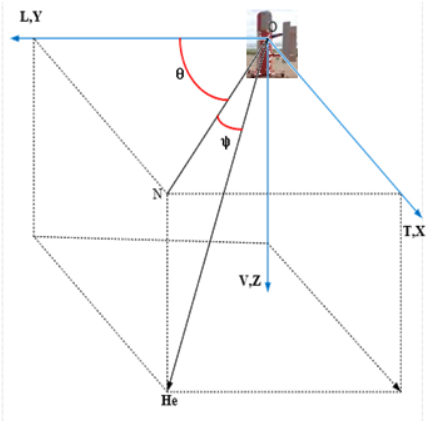
Figure 5. The towed bird coordinate